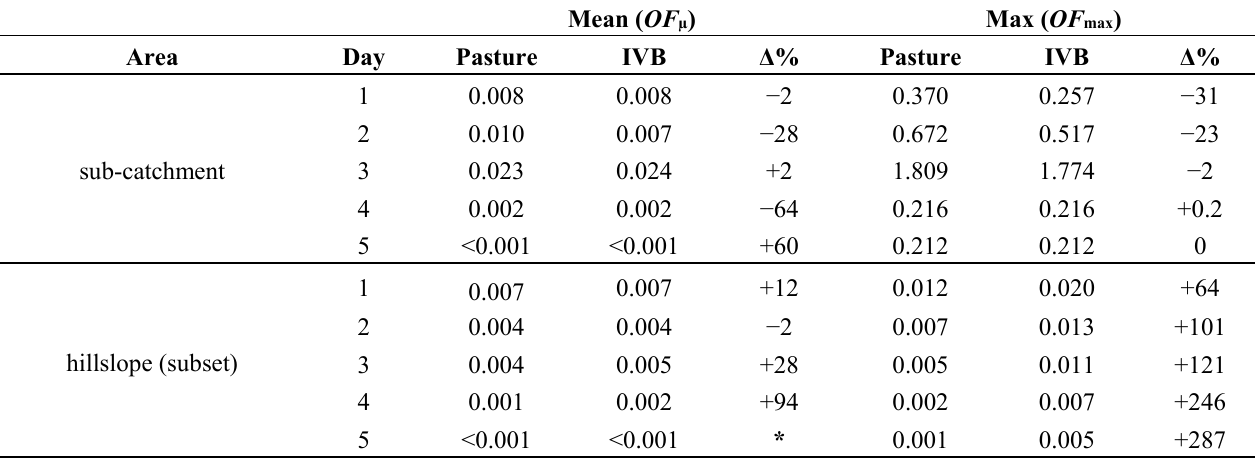
Table 2. Summary of overland flow depth ( OF ) (m). Mean ( OF µ ) Max ( OF max ) Area Day Pasture